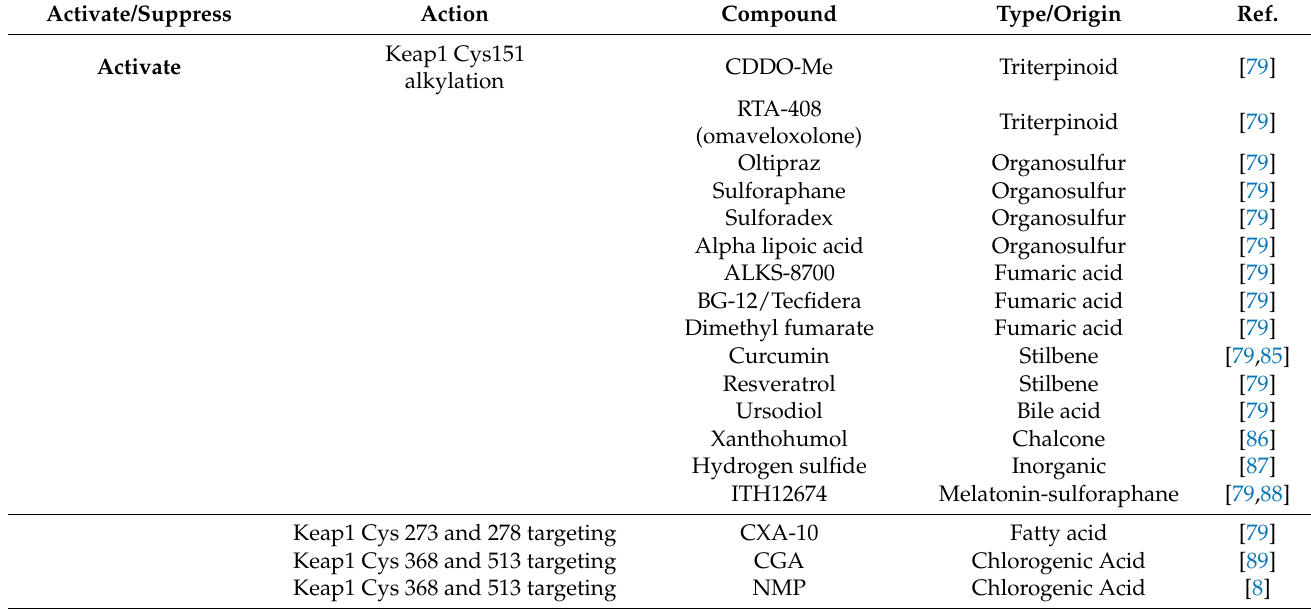
Table 4. Exogenous Activators/Suppressors of Nrf2